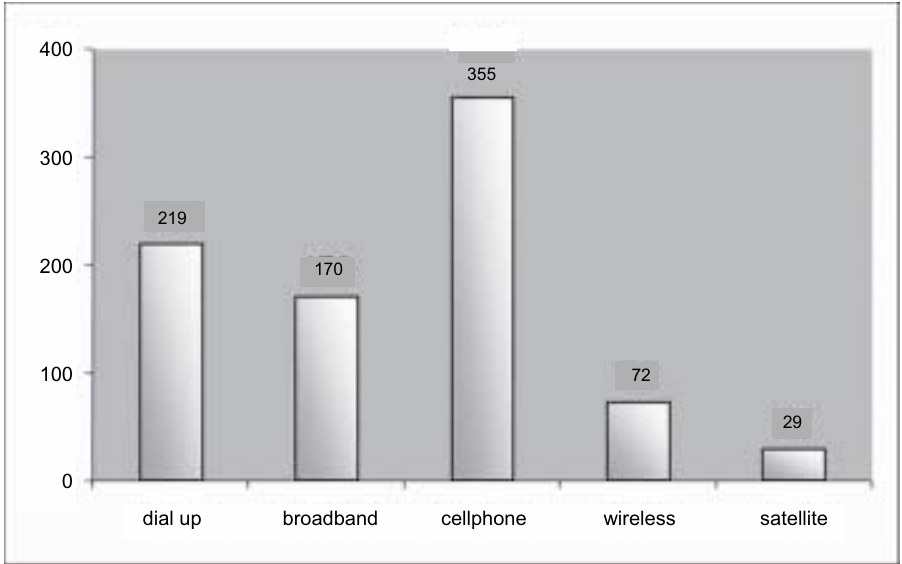
Figure 3. Type of connection off campus by socio-economic group (SEG).